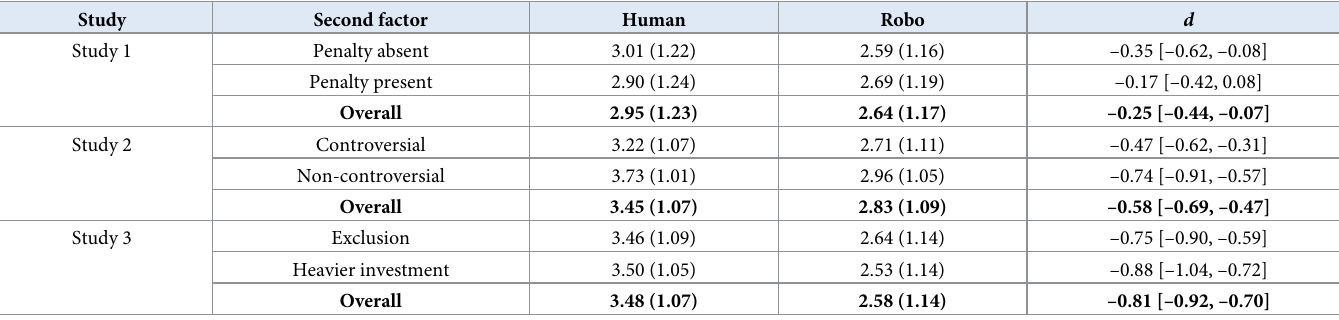
Table 1. Permissibility to make investment